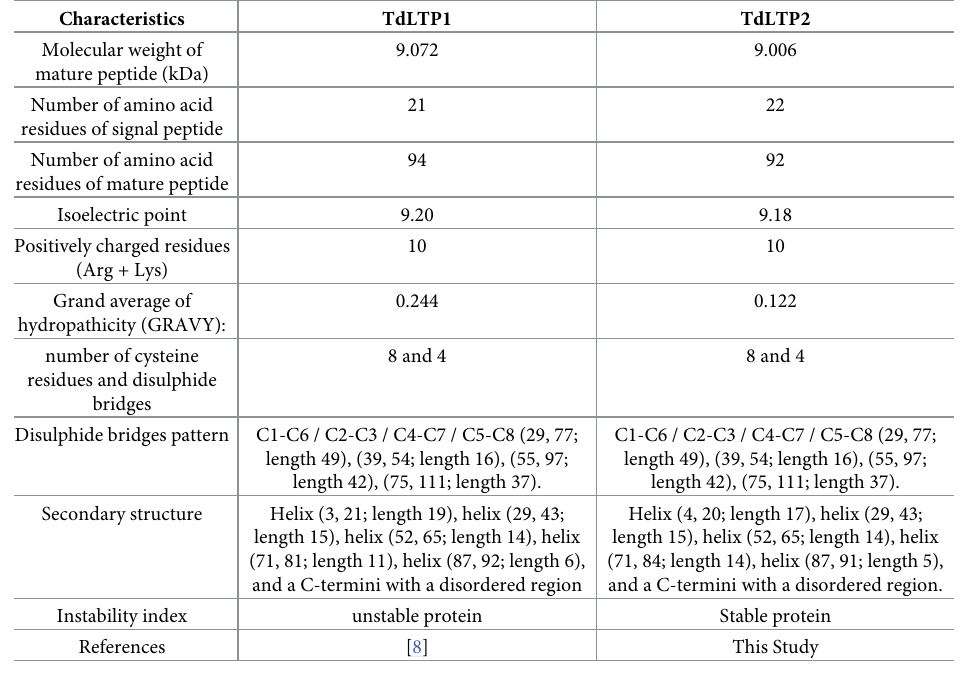
Table 1. The physicochemical features of TdLTP2 in comparison with TdLTP1, including protein length, calcu- lated molecular weight, theoretical pHi, stability index and grand average of hydropathicity (GRAVY), were determined using ProtParam